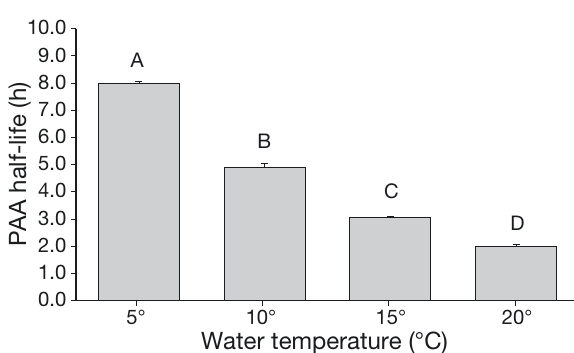
Fig. 2. Calculated PAA half-lives (mean ± SD) in full-strength seawater at 4 different temperatures, based on data from PAA decay with a nominal concentration of 1 mg l −1 PAA. Different letters denote significant difference (p < 0.01)